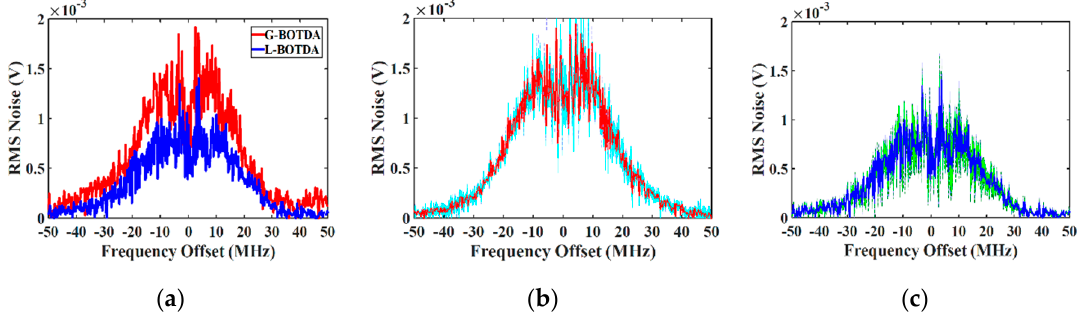
Figure 6. ( a ) Experimental measurement of the SBS-induced noise in dependence on frequency detuning for G-BOTDA and L-BOTDA; ( b ) the standard deviation error (cyan region) of the noise measurement (red curve) in G-BOTDA; ( c ) for L-BOTDA (green and blue).